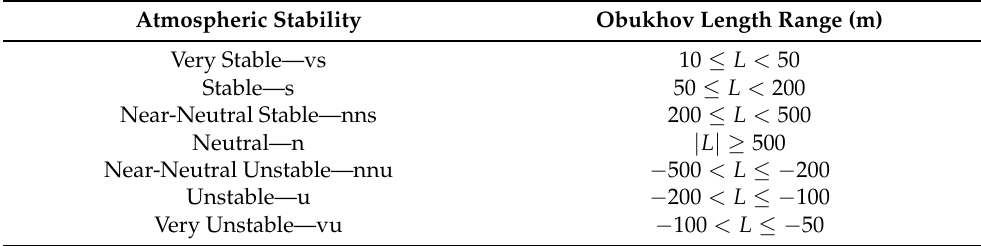
Table 3. Gryning et al.’s stability classes based on the Obukhov length, L . Adapted from